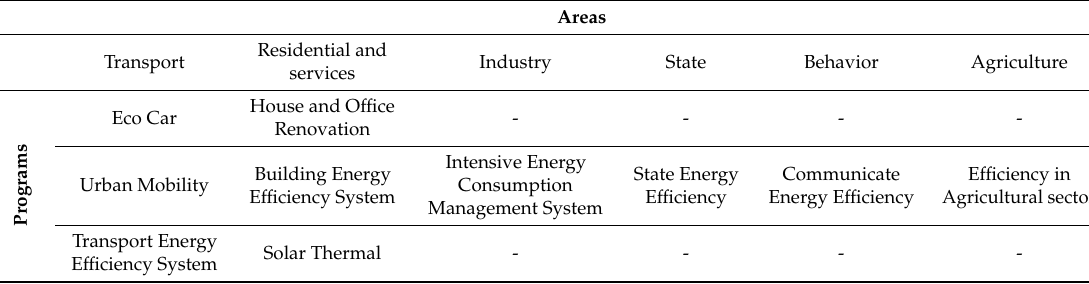
Table 1. Areas and programs considered in the NEEAP 2016